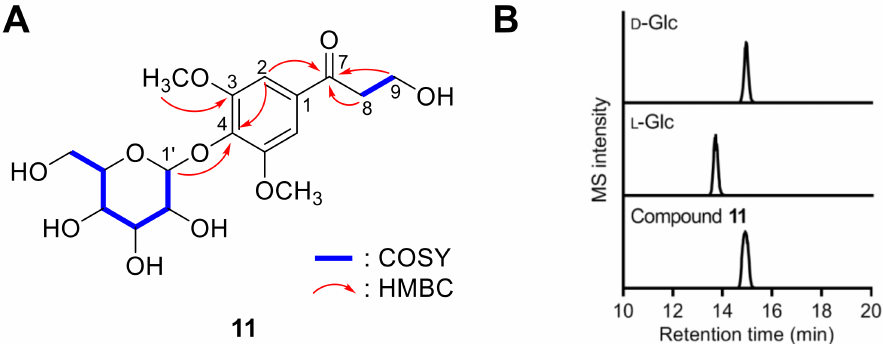
Figure 4. Structure elucidation of 11 . ( A ) Key COSY and HMBC correlations of 11 . ( B ) Extracted ion chromatograms (EICs, m / z 447.1260) of chiral derivatized D - and L -glucopyranose purchased or obtained by hydrolysis of 11